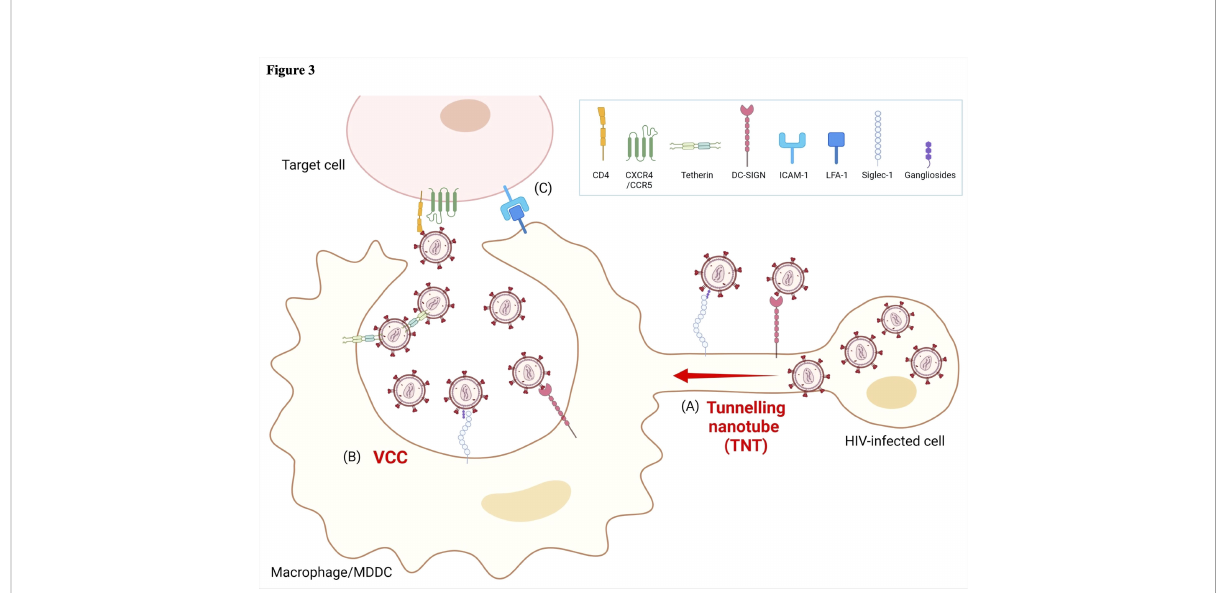
FIGURE 3 Models of HIV-1 cell-to-cell transmission in myeloid lineage cells. (A) HIV-1-infected cells form tunneling nanotubes (TNT) to transport infectious viral particles to other target cells by utilizing attachment receptors such as Siglec-1 or DC-SIGN. (B) Infected macrophages form unique virus-containing particles (VCC) and retain infectious viral particles through the association of tetherin, Siglec-1, or DC-SIGN with Env glycoprotein. When encountering other target cells, VCC containing either free virions or host factor(s)-associated virions may release infectious virus. (C) The binding of adhesion molecules LFA-1 and ICAM-1 has a well-characterized role in stabilizing virological synapse (VS) formation and contributes to cell-to-cell HIV-1 transmission. Image created with